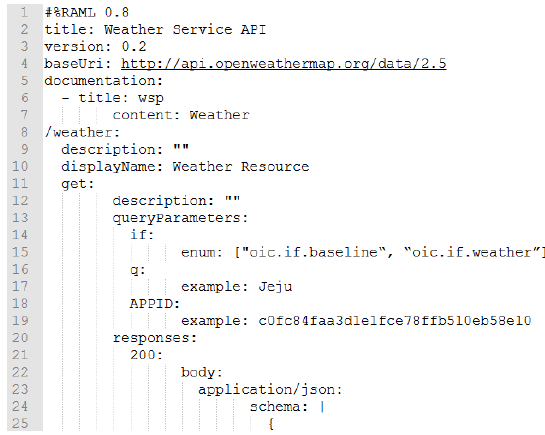
Figure 12. Fragment of RAML definition for registering WSP.